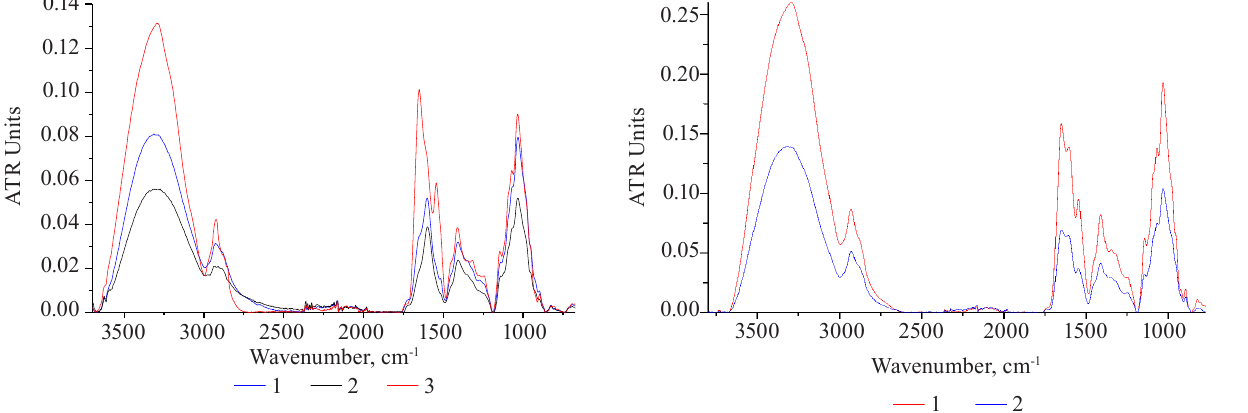
Figure 5 IR-spectra of extractions from two varieties of flax seeds: (1) primary PS-extract of industrial seeds, (2) primary PS-extract of LM-98varieties, (3) secondary PS-extract of industrial flax seeds